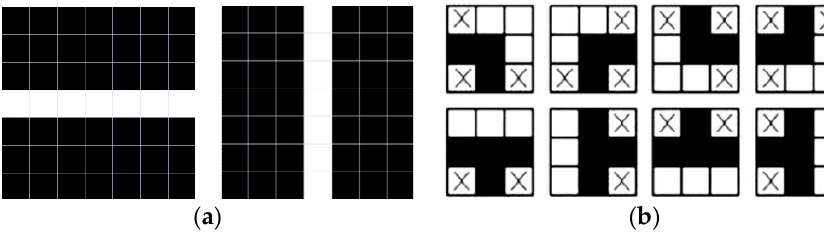
Figure 2. Filter kernels to highlight the areas of the image corresponding to the vertice of function i ( x , y ) ( a ); templates for skeletonization ( b ), mark “ × ” corresponds to pixels of any color. Thresholding of image L i and skeletonization of the obtained network of edges were performed prior to the segmentation of the edges of dimples. Skeletal image i s was obtained by multi-path overlay of templates on the resulting binary image (Figure 2b) [20]. The central black pixel was removed from each area corresponding to one of the templates. Since the edges of dimples should be interconnected, the “hanging” fragments of the skeleton were also removed. Figure 3 shows the initial images (Figure 1) with the well-defined edges of dimples attached to them. As a result of skeletonization, we obtain a set of points that describe the distribution lines between dimples. 3 × 3 pixels was used to the skeleton.